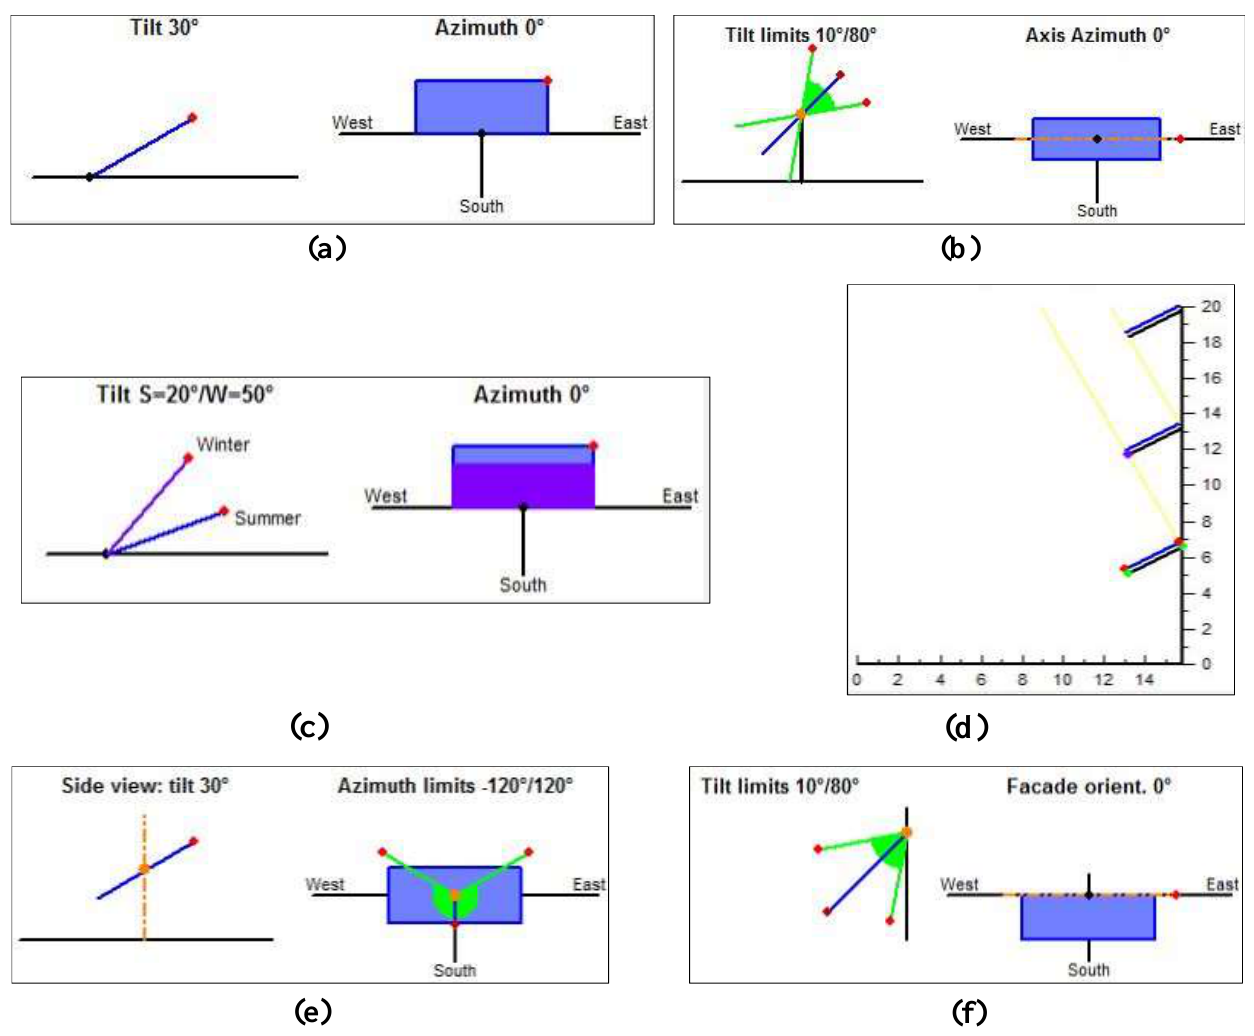
Figure 3: (a) tilt angle at 30° and azimuth at zero, (b) constant azimuth with varied tilt angle, (c) seasonal configuration with tilt angle is changing twice a year, (d) façade configuration, (e) tracking system with constant tilt angle and varied azimuth from east to west, and (f) tracking system with varied azimuth and varied tilt